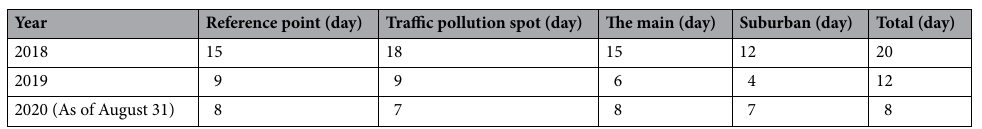
Table 3. Days of heavy PM 2.5 pollution in recent three years.